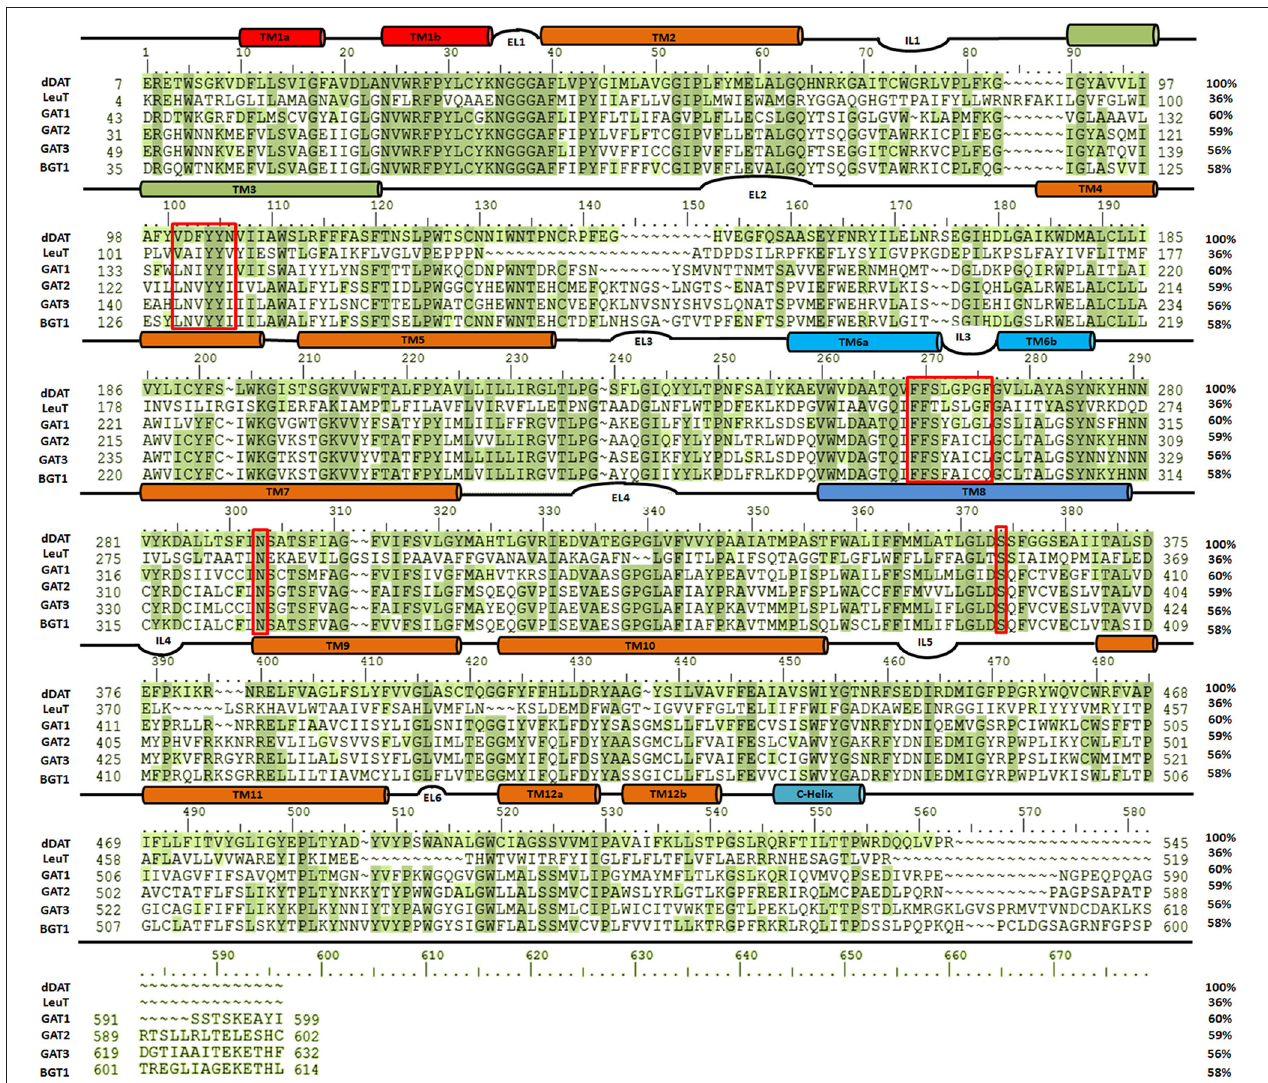
FIGURE 4 | Sequence similarity among dDAT (UniProt ID: Q7K4Y6), Aa LeuT (UniProt ID: O67854) and all four subtypes of GATs [UniProt IDs: GAT1 (P30531), GAT2 (Q9NSD5), GAT3 (P48066), and BGT1 (P48065)]. The multiple sequence alignment (MSA) was performed using Schrodinger alignment tool (Schrödinger Release, 2017). The red boxes highlight the amino acid residues of the respective substrate binding sites in the aligned homologous